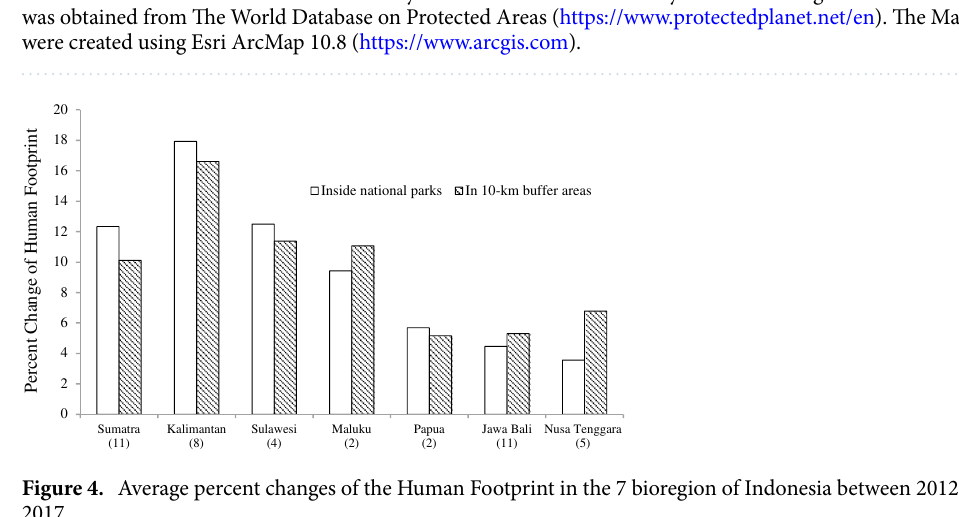
Tenggara (10.8%), and Manusela in Maluku (10.59%). Tanjung Puting, Rawa Aopa Watumohai, Meru Betiri, Manusela, and Lorentz also experienced the highest increase in their buffer areas, with 63.7%, 12.48%, 11.7%, 11.2%, and 10.2% respectively. Other buffer areas with high HFs are Laiwangi Wanggameti in Nusa Tenggara (16.3%) and Berbak in Sumatra (13.8%, Table 1). Tanjung Puting NP in Kalimantan (Fig. 5) experienced the greatest HF increase, both inside and outside the park. Tanjung Puting also experienced land transformation such as secondary swamp forest (peatland) becoming degraded due to agriculture and plantation expansion, illegal logging and forest fires 35 .